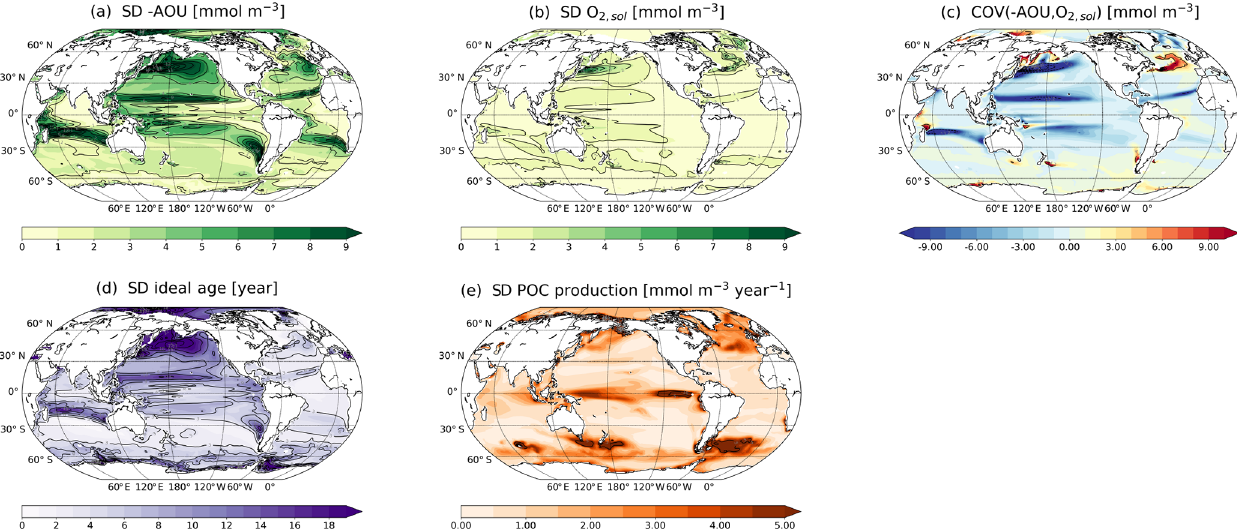
Figure 7. Standard deviation of annually and vertically averaged (200–600m) (a) − AOU, (b) O 2 , sol , (d) ideal age and (e) particulate organic carbon (POC) production during the last millennium (850–1800CE) and (c) the corresponding covariance between − AOU and O 2 , sol